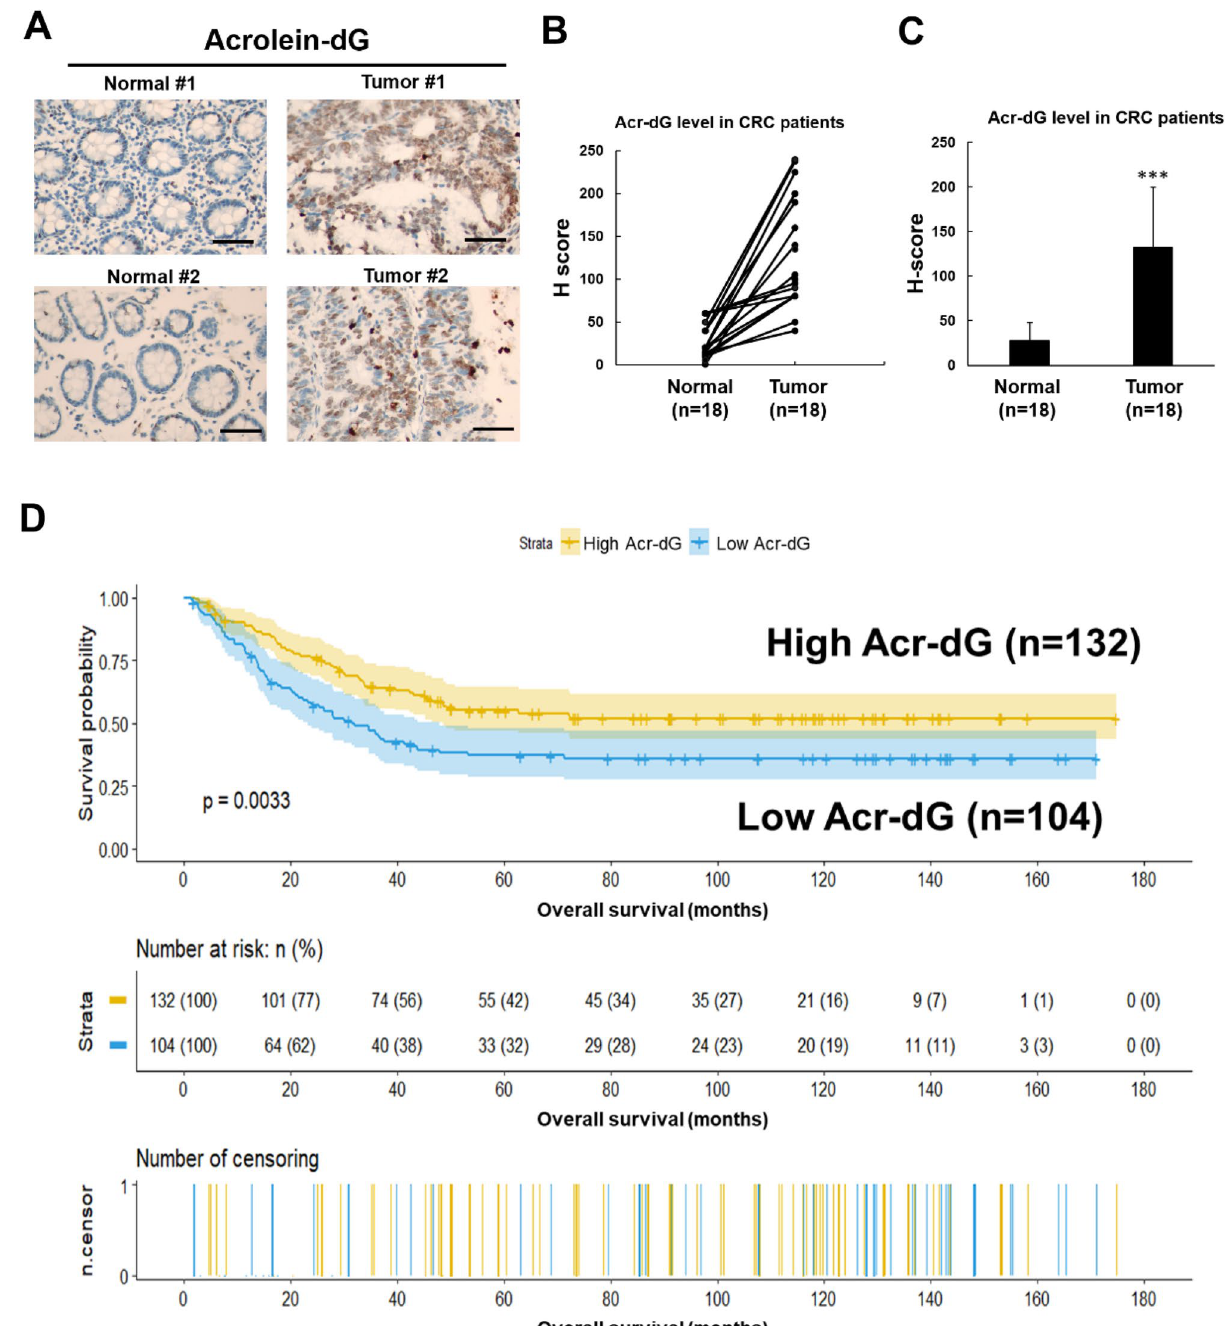
Figure 5. Immunohistochemical staining for Acr-dG adducts in eighteen CRC patients and Kaplan–Meier survival analysis of the high and low Acr-dG expression groups in CRC patients. (A) Representative image of Acr-dG adducts in normal epithelial cells adjacent to CRC tumor tissues (magnification, × 400). Scale bar: 50 μm. (B,C) Quantification of Acr-dG adducts in normal epithelial cells adjacent to CRC tumor tissues. (B) Relative Acr-dG levels between normal and tumor tissues in 18 individual CRC patients. (C) Average Acr-dG levels in normal tissues and tissues from 18 CRC patients. Student’s t tests were used to determine statistical significance, and two-tailed p-values are shown. *p < 0.05, **p < 0.01, ***p < 0.005 compared between tumor tissues and normal tissues. (D) IHC analysis of Acr-dG levels in CRC tissues (n = 236) was performed as described in the “Materials and Methods”. The Kaplan–Meier survival analysis survival plot was analyzed with the R software (R version 4.1.0). The number at risk and the number of censors in study cases are listed. Additionally, the endpoint was cancer-specific